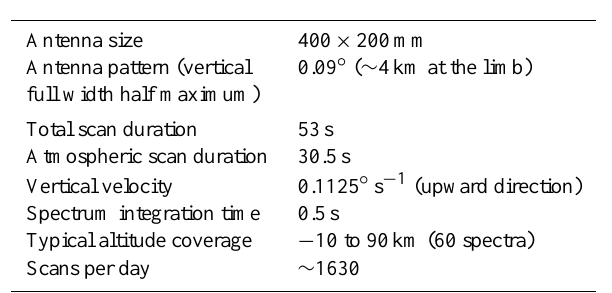
Table 1. Characteristics of the SMILES antenna and the observa- tion sequence.